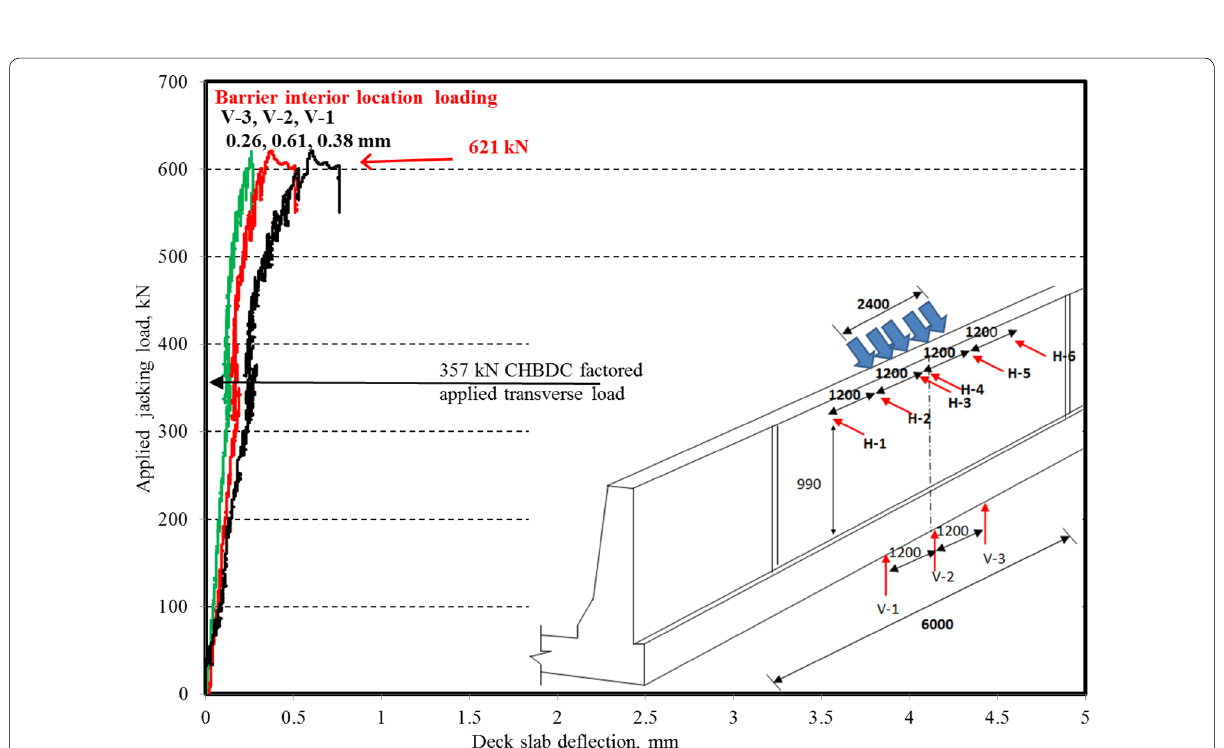
Fig. 15 Load-deflection relationship for the deck cantilever of barrier segment at mid-length between two control